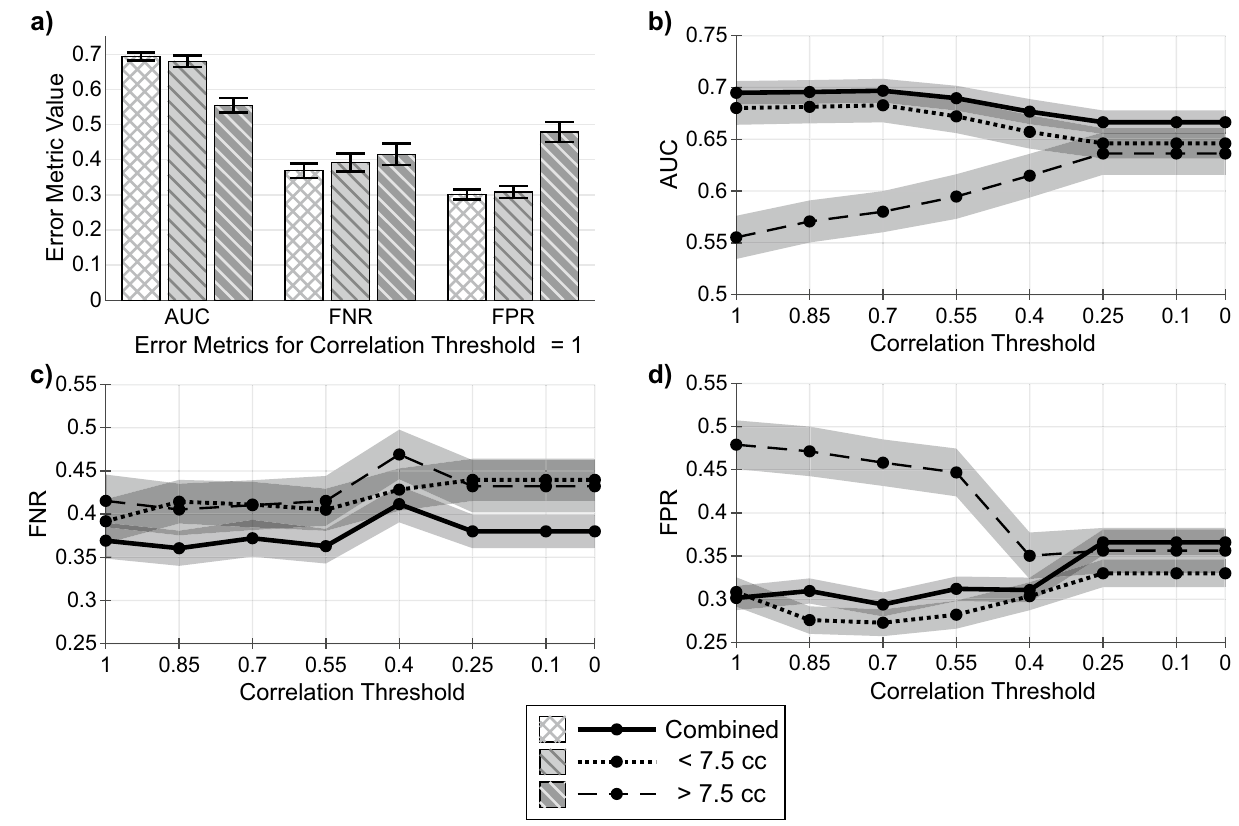
Figure 2. Volume dependency of error metrics. ( a ) Shows the comparison of error metrics between all BMs, BMs with volume < 7.5 cc, and BMs with volume > 7.5 cc before the removal of any volume-correlated features. ( b – d ) show the AUC, FNR, and FPR for each BM volume group as a function of the feature volume-correlation coefficient threshold value used to remove continuous features, with correlation threshold = 1 corresponding to the removal of no features (baseline). At all correlation thresholds < 1, categorical clinical features dependent on BM volume are also removed. For example, values at correlation threshold = 0.7 represent the error metric values when the experiment was repeated with all features with volume-correlation coefficient values greater than 0.7 removed. For all values, a 95% confidence interval is provided by error bars or shaded